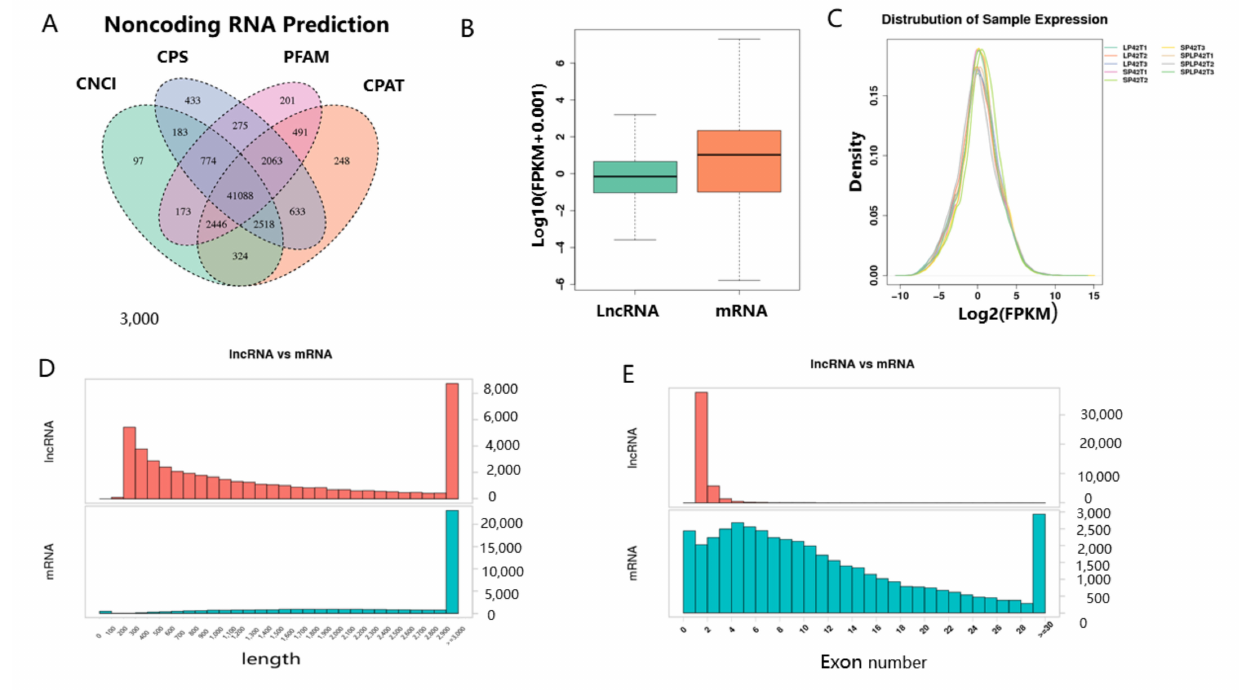
Figure 1. Identification of lncRNAs and mRNAs in the ewes thyroid gland. ( A ) Venn shows the common and unique number of novel lncRNAs by four methods, including CNCI, CPC, PFAM, and CPAT. ( B ) The expression level of lncRNAs and mRNAs. ( C ) FPKM distribution of each sample. ( D ) The length statistics of lncRNA and mRNA. ( E ) The statistics of lncRNA and mRNA exon